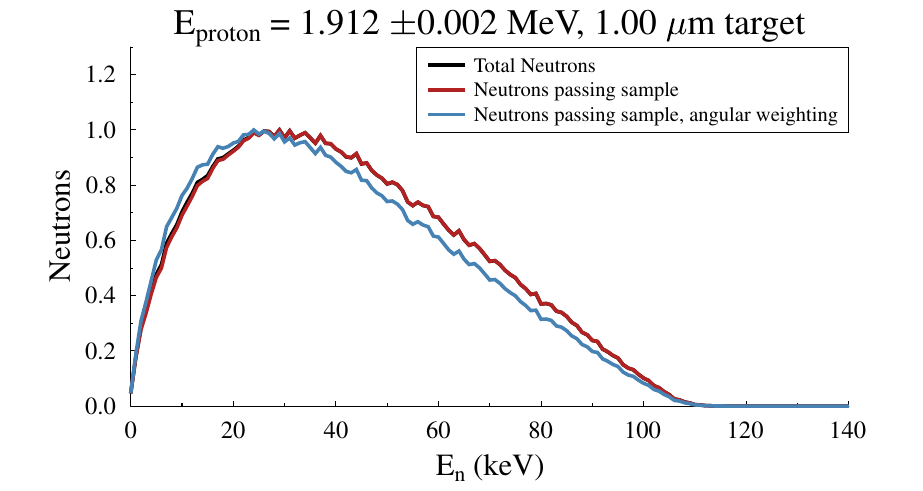
Figure 2. Comparison of the number of angle-integrated neutrons per linear energy bin for a simulation that contain weighting and no weighting for a sample with a radius of 3 mm. The radius of the Li-spot is 3 mm. The simulated spectrum is normalized to a common maximum of